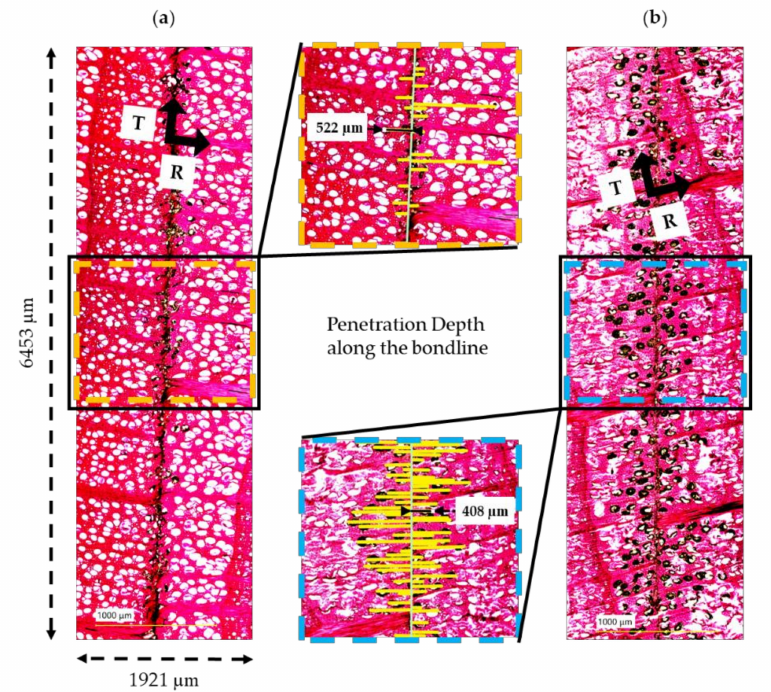
Figure 5. Images of adhesive penetration by brightfield microscopy on differently cut and anatomi- cally almost identically aligned finger joints; the penetration depth of the adhesive in a predominantly radial direction is shown; a section (1921 × 6453 µ m 2 ) of the adhesive joints was examined via stitched images and the penetration was measured (yellow lines) perpendicular to the bondline; exemplary beech finger joints cut before bonding with ( a ) Cu1 (blunt) and F R 1 (4 m min − 1 ) and ( b ) Cu3 (sharp) and F R 1 (4 m min − 1 ) are